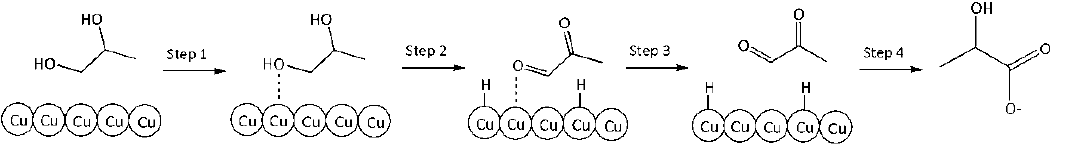
Figure 9. A schematic conversion of PG into LA on the catalyst surface.